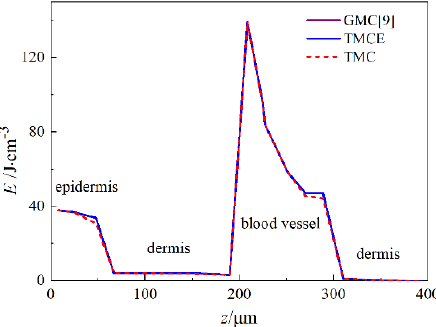
Figure 6. Line graph of energy deposition vs. depth at the beam center for simulations of skin with a single blood vessel.